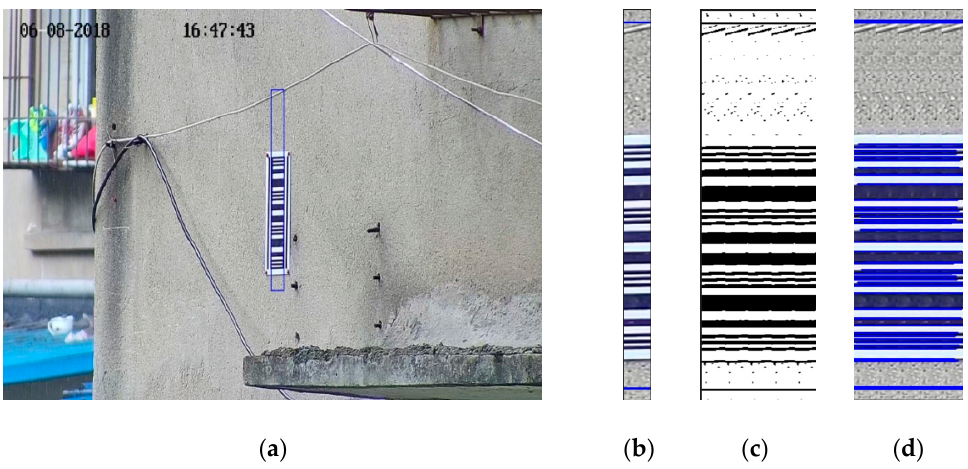
Figure 5. The process of the line detection on the mark, ( a ) the region of the mark recognized on the image; ( b ) the remaining middle part of the region of interest (ROI); ( c ) five RIOs; ( d ) the line extraction result of Hough transformation.